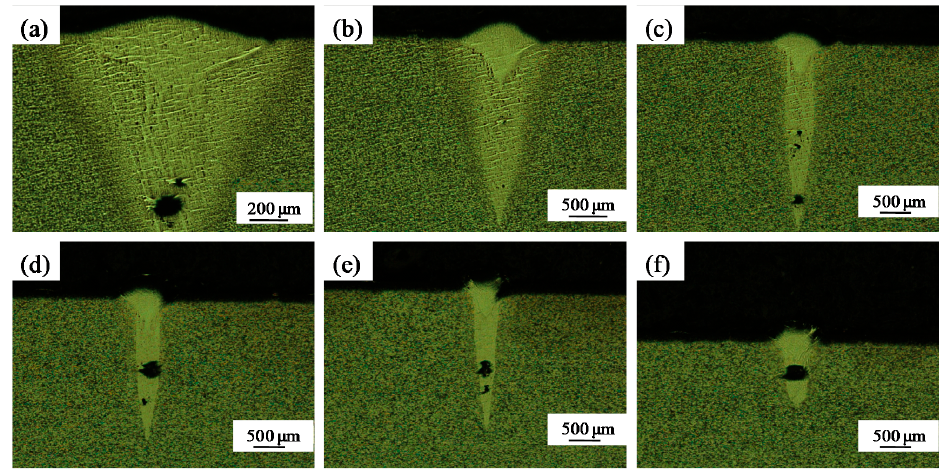
Figure 5. Optical micrographs showing the cross-sections of single-scan tracks produced with a small-diameter (50 µm) laser beam (P = 400 W, δ = 200 µm). ( a ) v = 25 mm/s; ( b ) v = 50 mm/s; ( c ) v = 75 mm/s; ( d ) v = 100 mm/s; ( e ) v = 150 mm/s; ( f ) v = 200 mm/s.